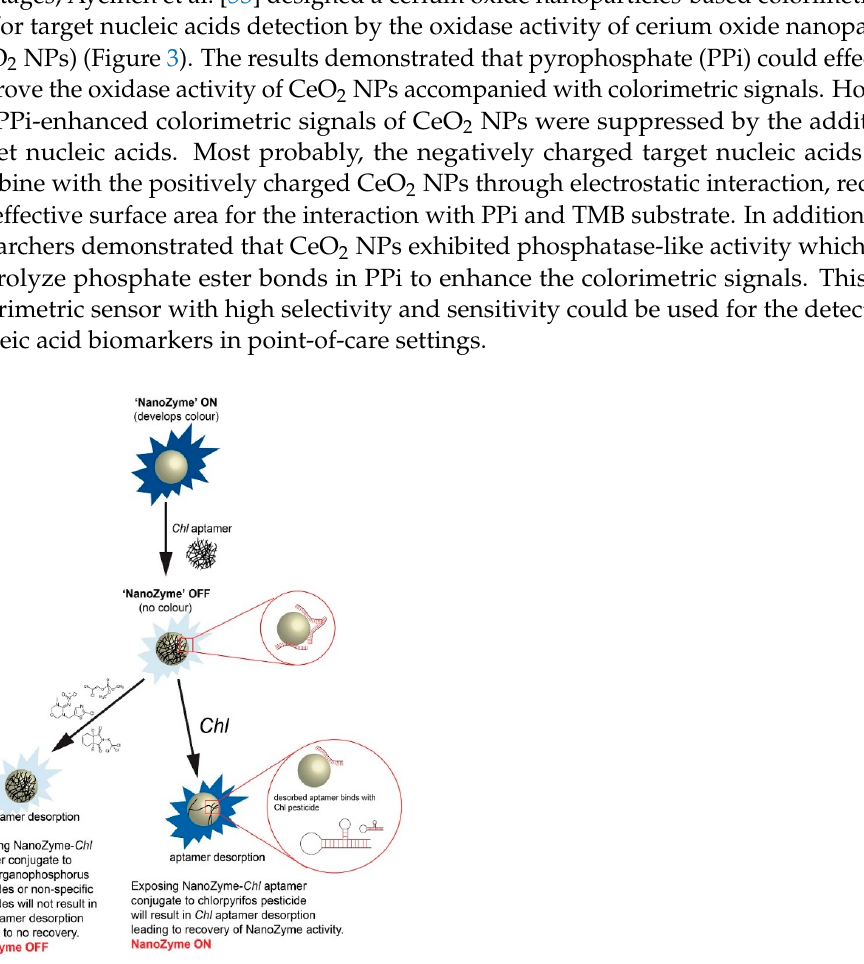
Figure 2. The working principle for chlorpyrifos aptasensor. Reprinted with permission from Ref. [51]. Copyright 2019 Elsevier.